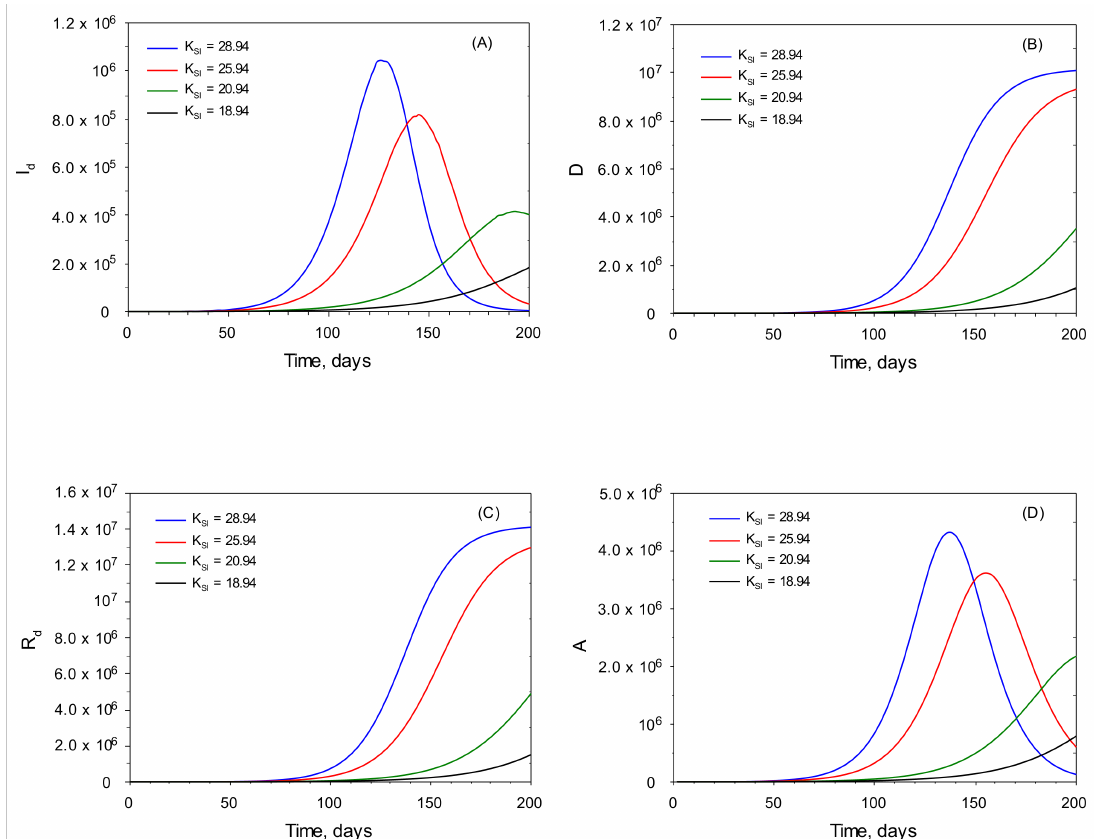
Figure 4. Calculated plots of those diagnosed, infected, dead and recuperated for increasing values of the basic infectivity coefficient, K SI . ( A ) detected, ( B ) dead, ( C ) recovered and ( D ) assisted